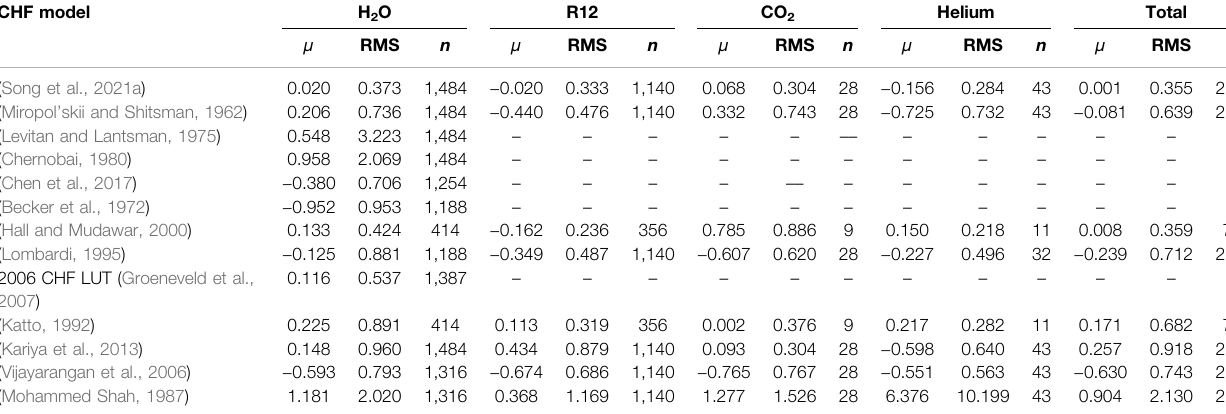
TABLE 4 | Predictive capability of CHF models for water experiments. CHF model